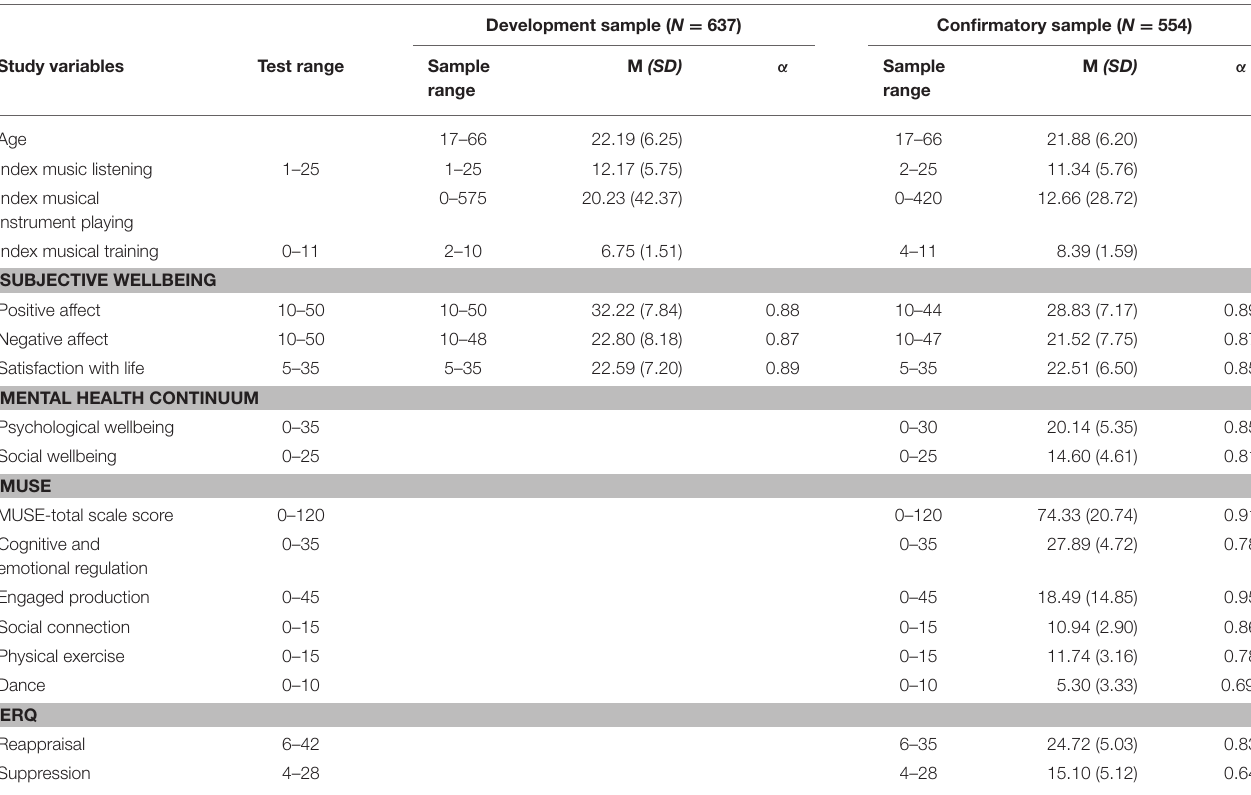
TABLE 2 | Participant characteristics and descriptive statistics for all measures included in two phases of data collection with the development sample and a separate confirmatory